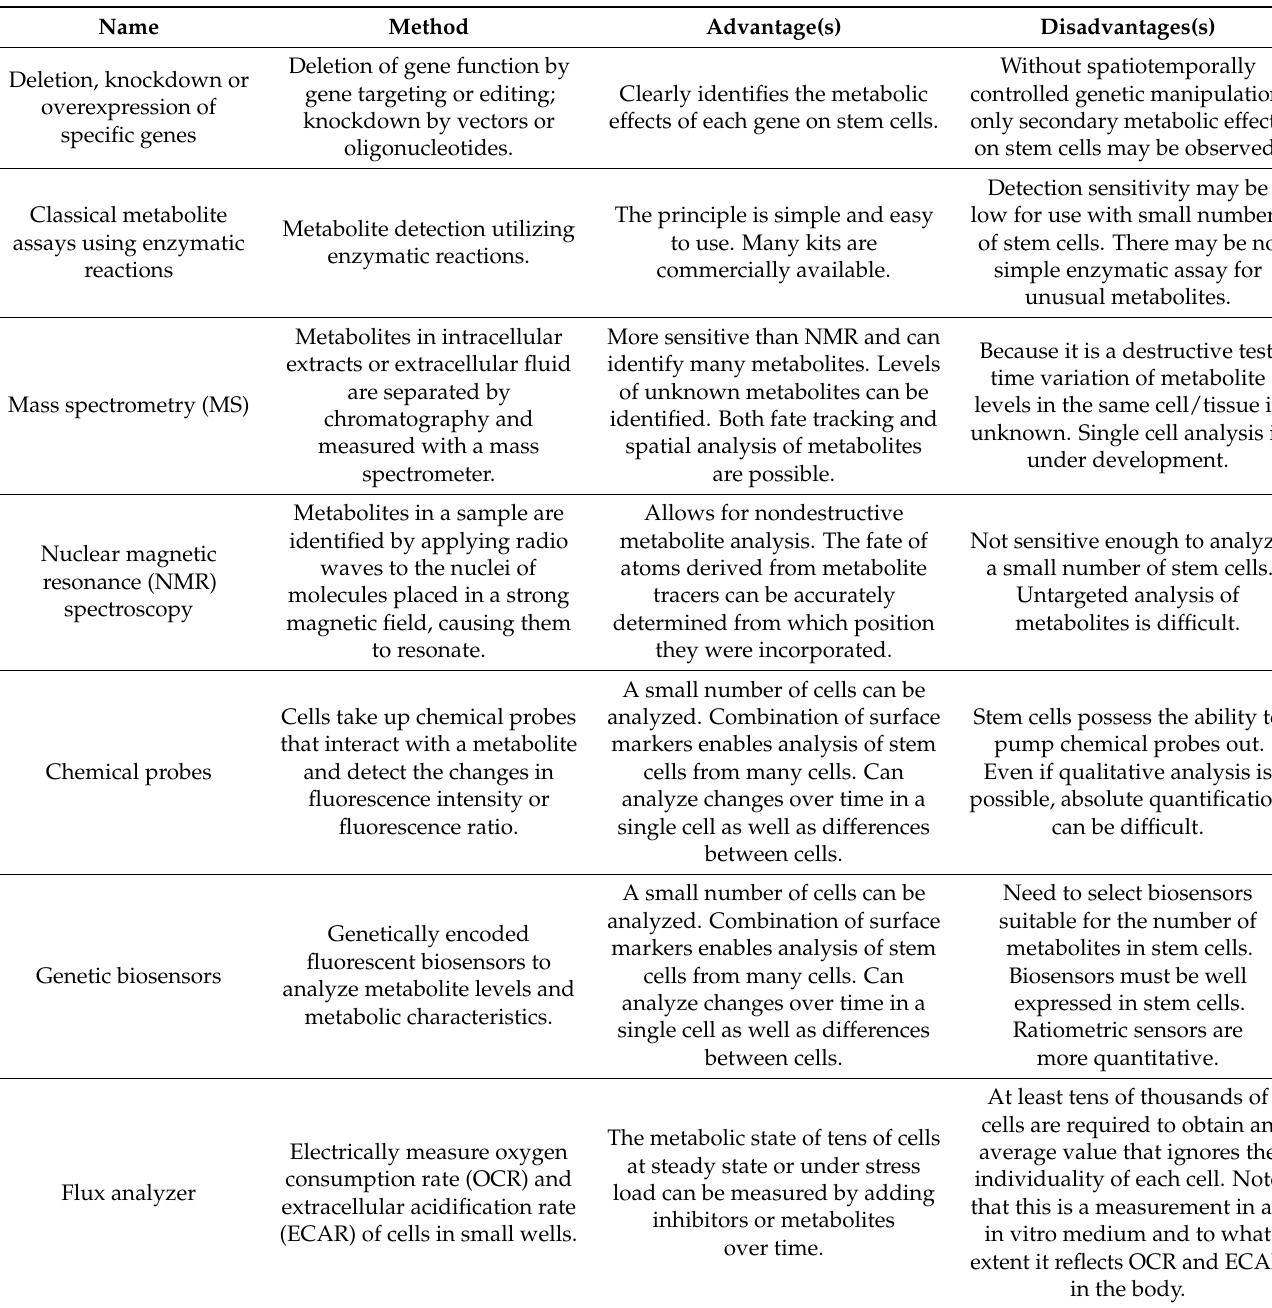
Table 1. Description, advantages, and disadvantages of the methods used in the approaches to studying stem cell